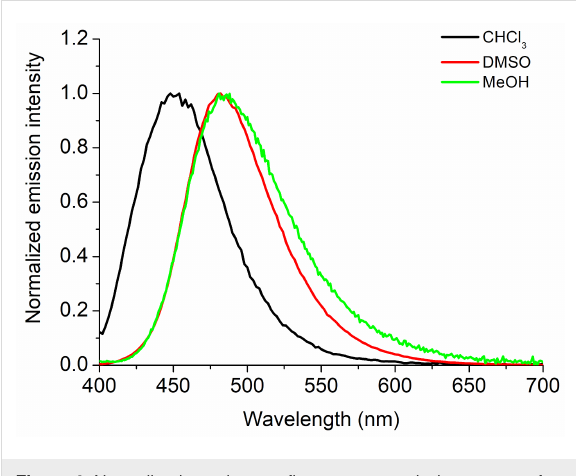
Figure 4: Normalized steady-state fluorescence emission spectra of compound 3aa (R = Ph, R 1 = H) in CHCl 3 (black solid line), DMSO (red solid line) and MeOH (light green solid line) solutions ([ ] = 1.50 × 10 − 5 M).